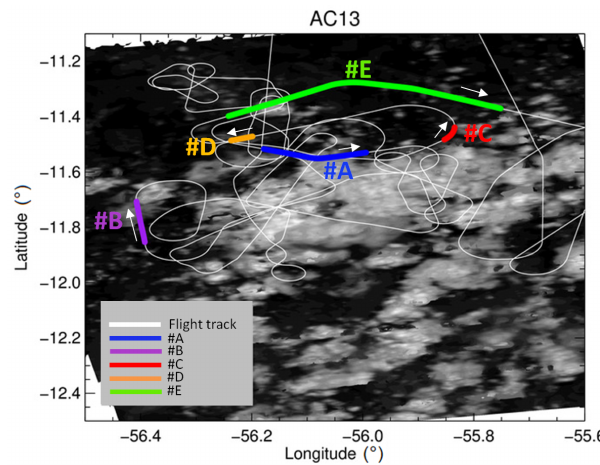
Figure 7. Flight track (white line) and selected time periods of cloud-side observations during AC13 (19 September 2014). Addi- tionally, the 250m resolution product for channel 1 (620–670nm) of the Aqua-MODIS instrument from 17:50UTC is shown in the background. Figure is similar to that presented in Jäkel et al. (2016).